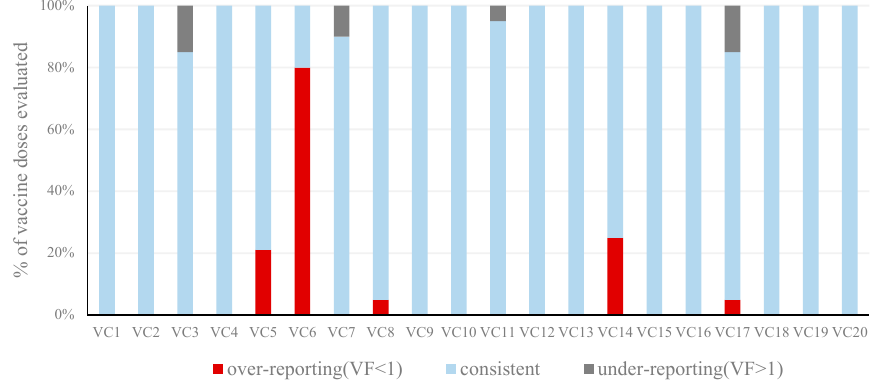
Figure 1. Distribution of verification factors (VFs) of the 20 vaccine doses among 20 vaccination clinics in Shangyu District, 2014.